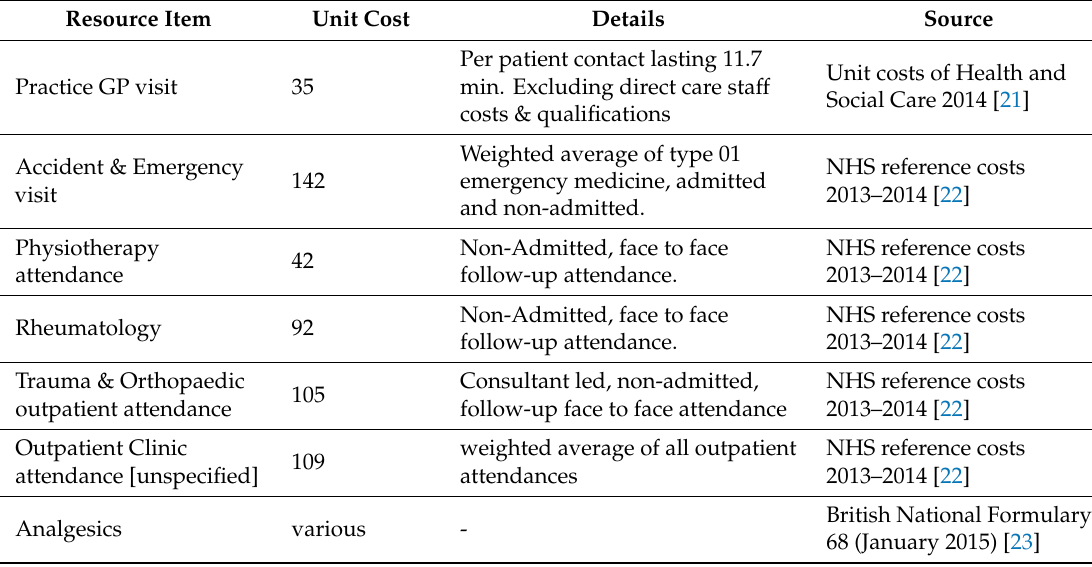
Table 5. Unit costs of health services (£ UK).